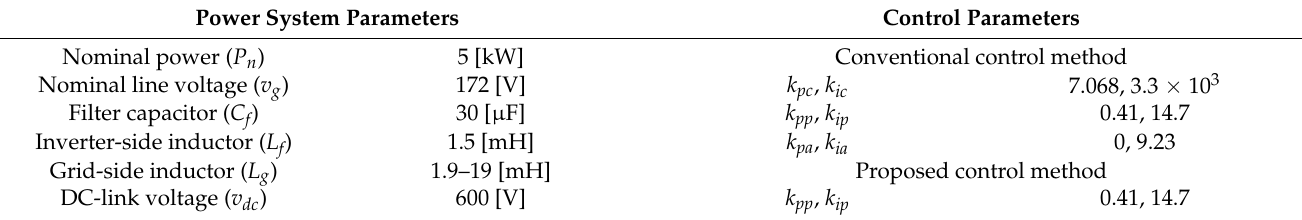
Table 6. System and control parameters of down-scaled power